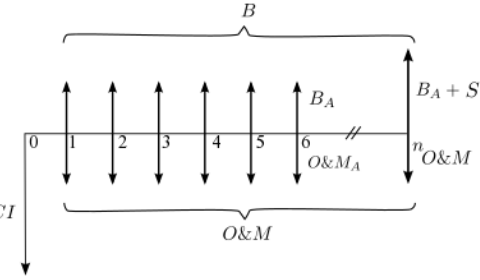
Figure 8. Typical cash flow of a wind power project. IC represents the initial investment, which is composed of the wind turbine costs and is related to the installation. B A represents the annualized economic benefits produced by the sale of electricity. The annualized operation and maintenance costs are denoted by O & M A . Finally, in the final year of the project, extra income known as the salvage value S is